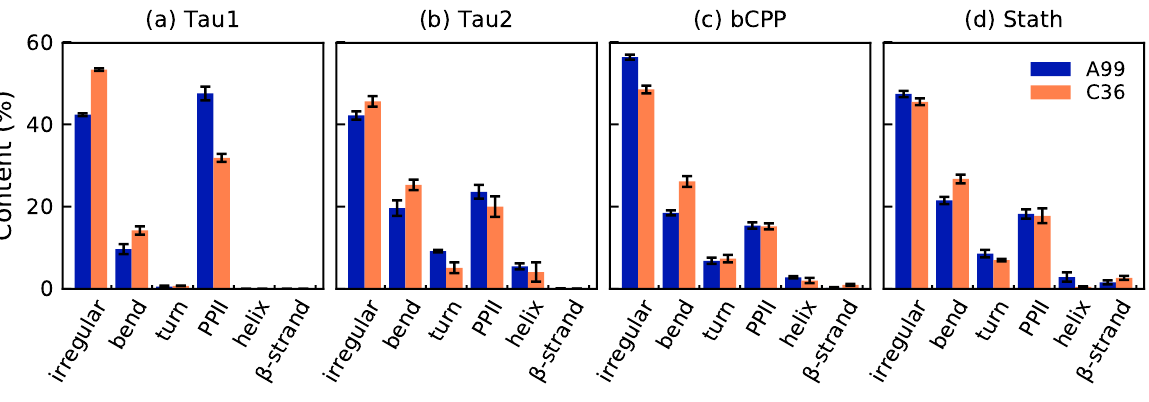
Figure 4. Average content of different types of the secondary structure in ( a ) Tau1, ( b ) Tau2, ( c ) bCPP, and ( d ) Stath simulated with Amber ff99SB-ILDN (A99) and CHARMM36m (C36). The legend applies to all panels. The helix includes the α - 3 10 - and a negligible content of the π -helix, while the β -strand also includes β -bridge. Error bars correspond to errors calculated by block